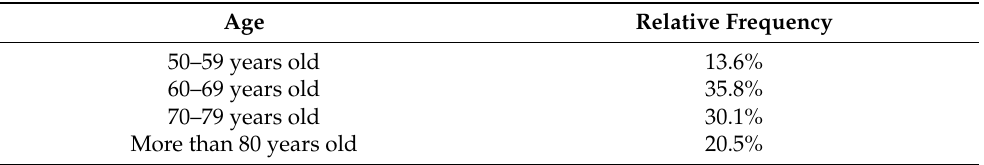
Table A2. Age distribution of SHARE COVID-19 survey in